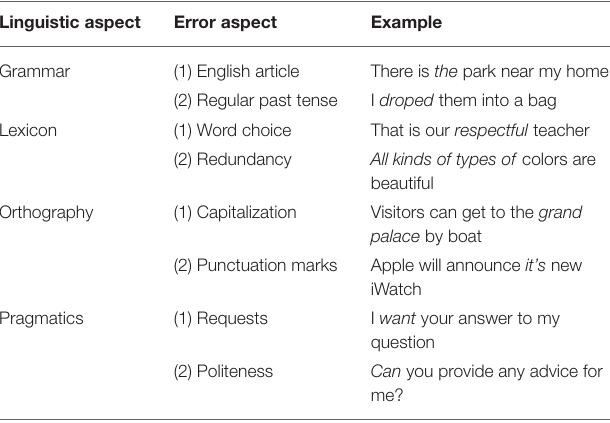
TABLE 4 | Error examples provided in the written corrective feedback preference questionnaire (WCFPQ). Linguistic